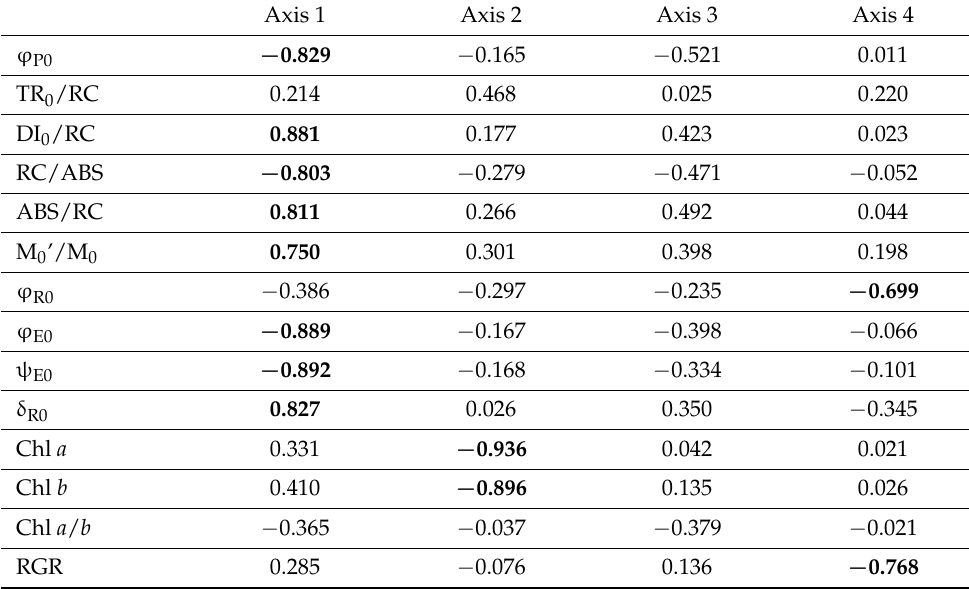
Table 2. Loading scores of JIP-test, chlorophyll content and relative growth rate (RGR) parameters in the redundancy analysis (RDA) in temperate and subtropical forests. The correlation coefficients ( ρ ) are shown in the matrix. For further information, see Table 1. Axis = RDA